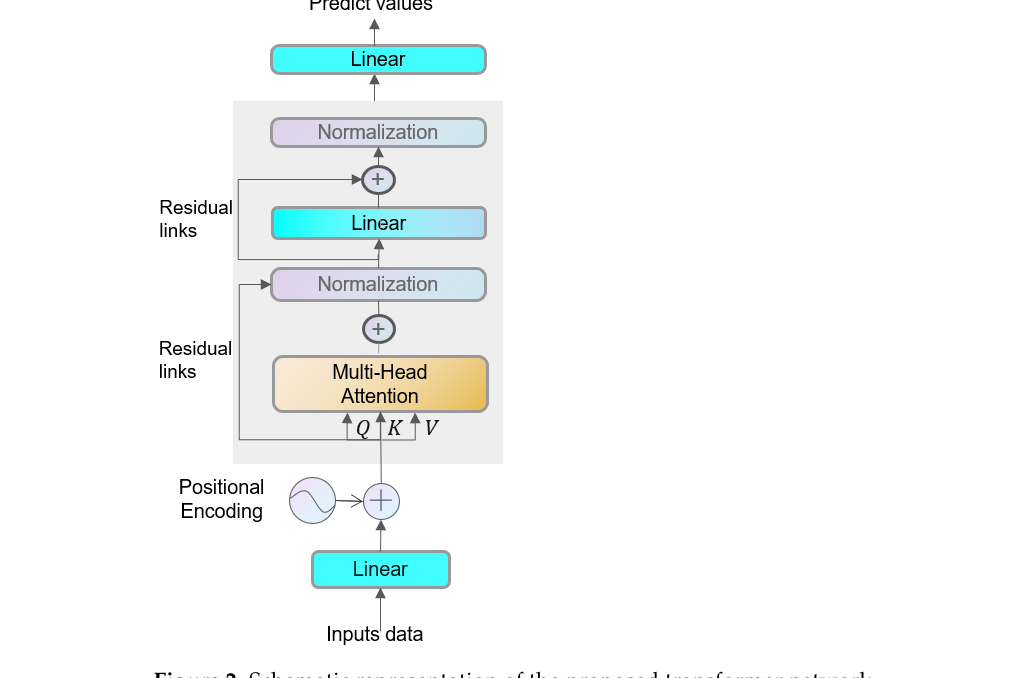
Figure 2. Schematic representation of the proposed transformer network.